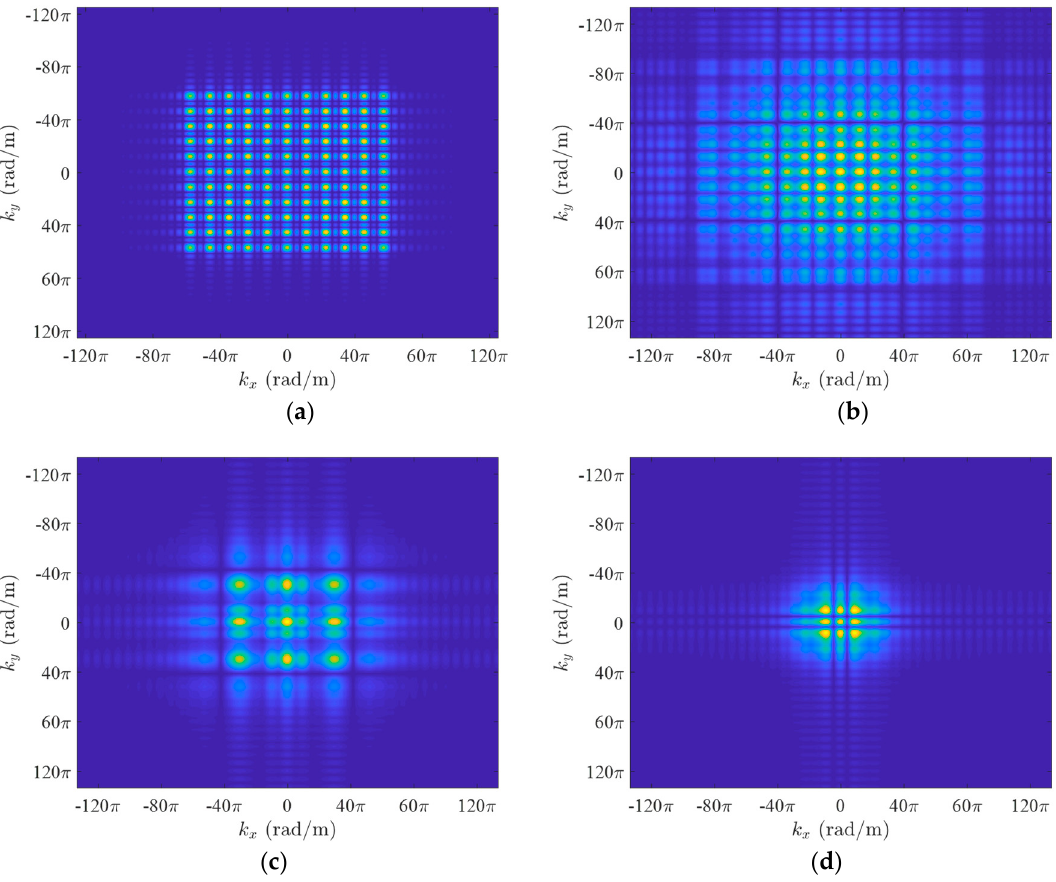
Figure 2. The low-pass filter demonstrated by the comparison in the k-space: ( a ) | (cid:101) J m | and corresponding spectrum of measurement modes at the imaging range of ( b ) 1 m, ( c ) 2 m and ( d ) 4 m.